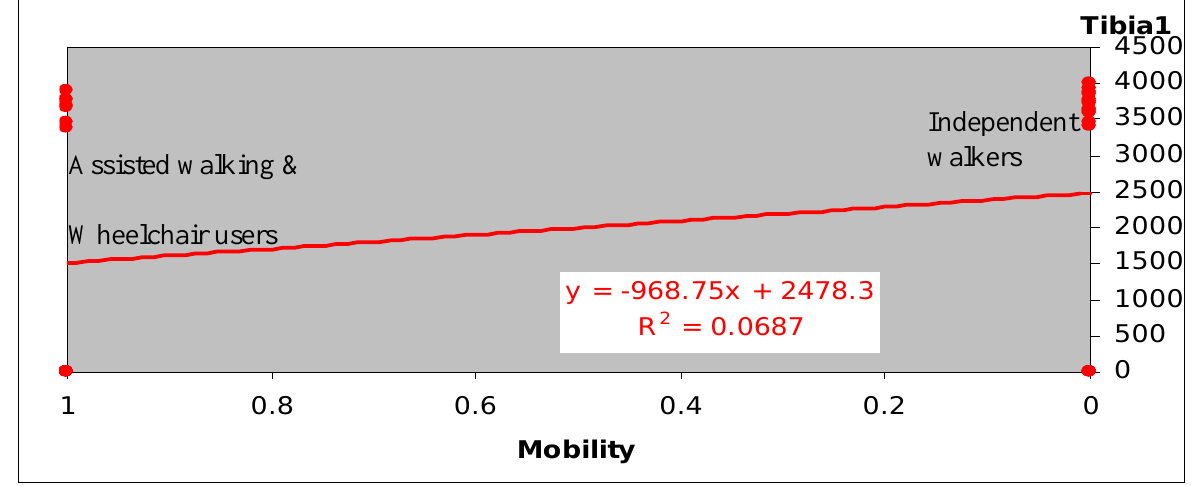
FIGURE 6 . The connection between mobility and tibia bone strength.